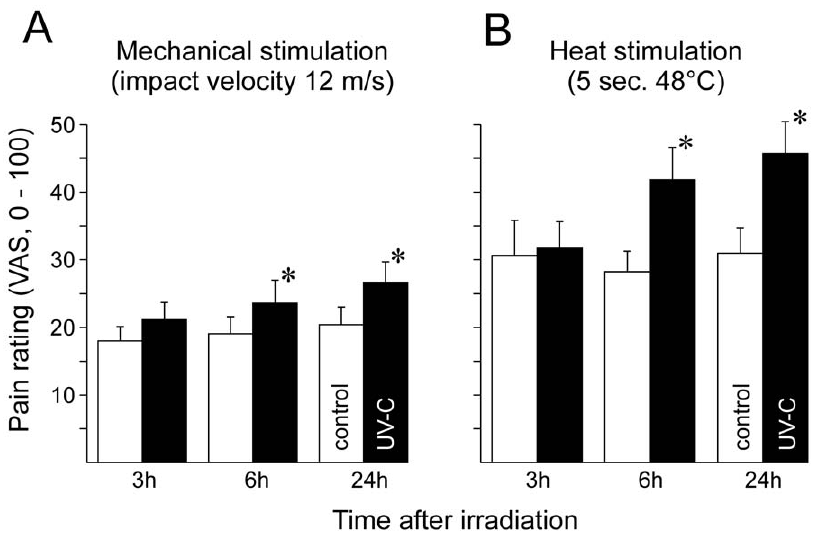
Figure 1. Pain ratings (VAS, 0–100) upon (A) mechanical and (B) heat stimuli. Mechanical impact stimuli were delivered at 12 m/s and continuous heat applied for 5 sec at 48 u C. Responses recorded at 3, 6 and 24 h post irradiation are depicted in open columns from untreated skin and those recorded from UV-C treated skin (5-fold MED) in black columns. Asterisks indicate significant differences between control and UV-C skin (p , 0.01, Fishers LSD test).